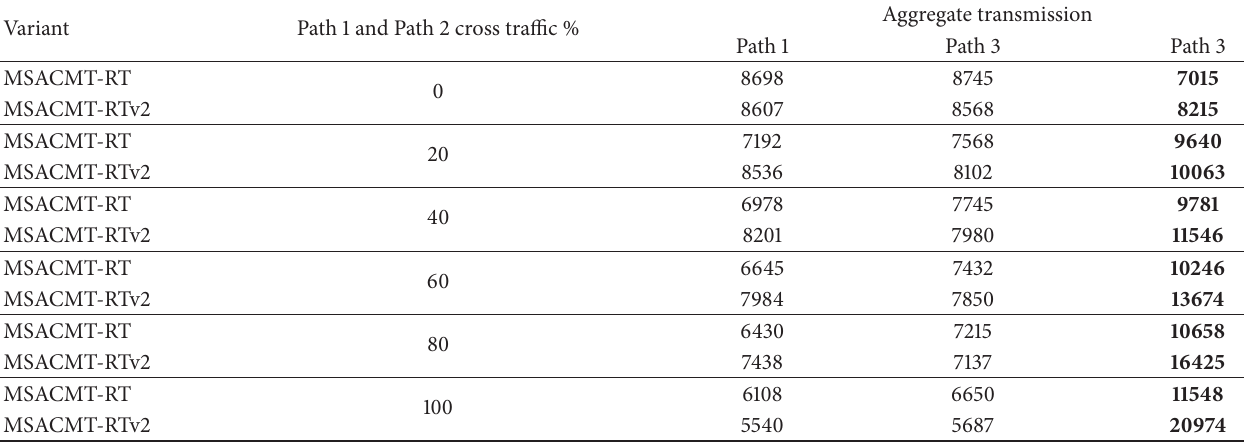
Table 5: MSACMT-RTv2 versus MSACMT-RT mean number of transmission.